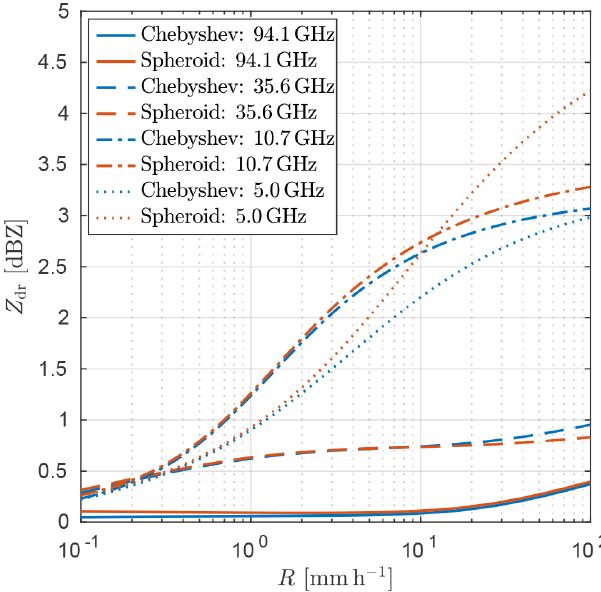
Figure 4. Differential reflectivity Z dr as a function of rainfall rate R at multiple frequencies using the side